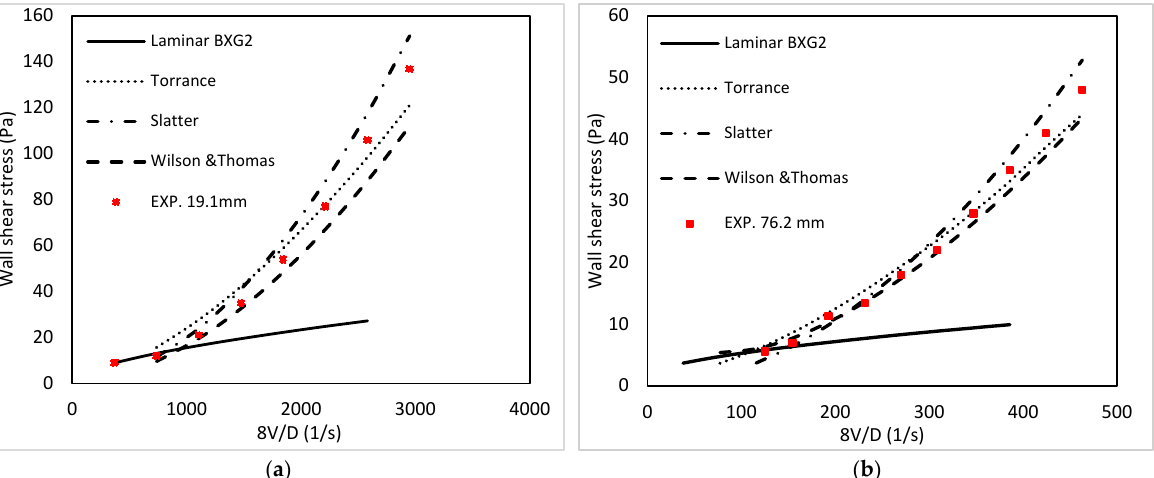
Figure 10. Comparison between predictions and experimental data of turbulent flow for BXG2 Herschel–Bulkley fl uids: ( a ) pipe diameter 19.1 mm, ( b ) pipe diameter 76.2 mm. The Wilson and Thomas [26] method gave underpredictions in both diameters: Ø19.1 mm and Ø76.2 mm. The error decreased as the pipe diameter increased, which followed the shape of the experimental data at a lower shear stress range with a mean absolute relative error of 11.2 and 8.7%, respectively, when using the Herschel–Bulkley model. The Torrance [28] method overpredicted at low turbulent shear stress for both small and larger